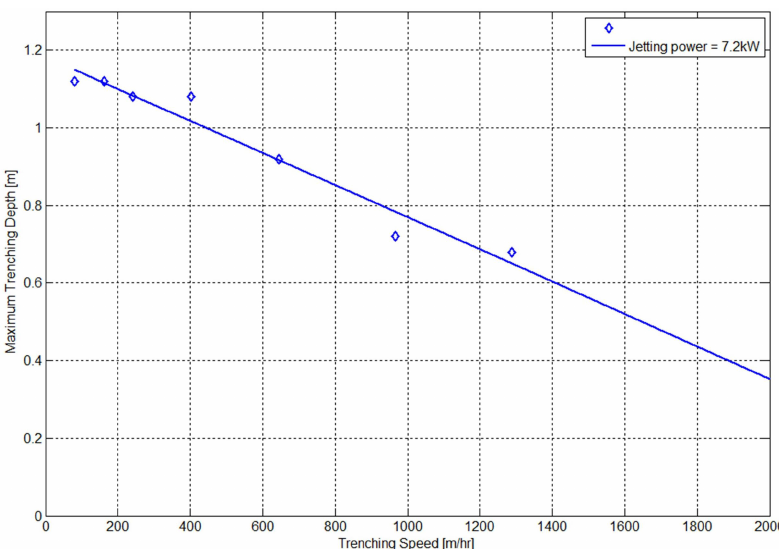
Figure 10. Extended trend of jetting power and trench speed on the maximum trench